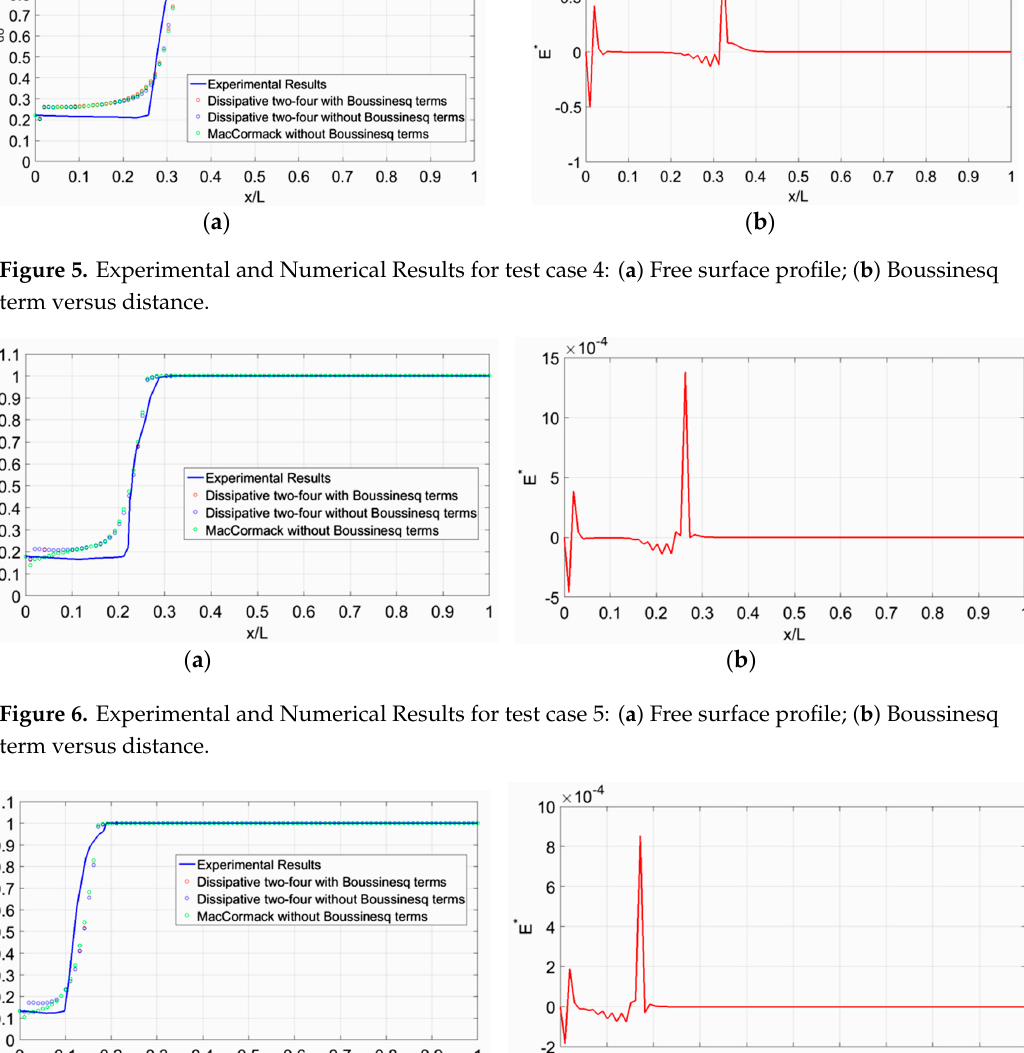
Figure 7. Experimental and Numerical Results for test case 6: ( a ) Free surface profile; ( b ) Boussinesq